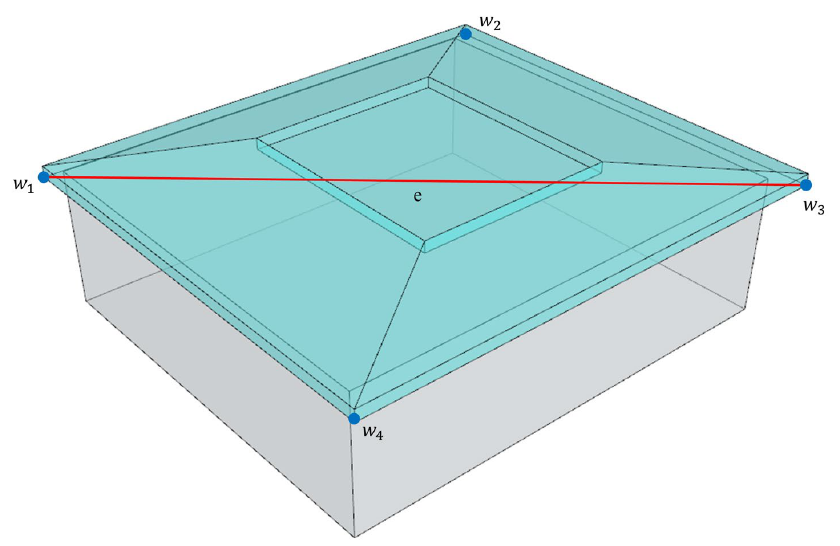
Figure 11. "Embedded" relationship between components. Edge e is the boundary edge. Both vertices of it can be identified as boundary vertices ( w 1 and w 3 ) . The other two vertices of the bottom quadrilateral are recognized as ordinary vertices ( w 2 and w 4 ) and cause errors.